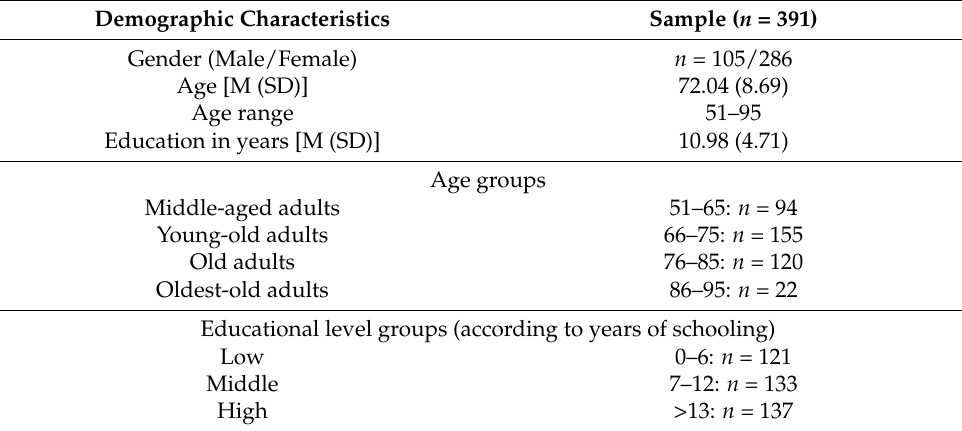
Table 1. Demographic characteristics of the participants of the study. Demographic